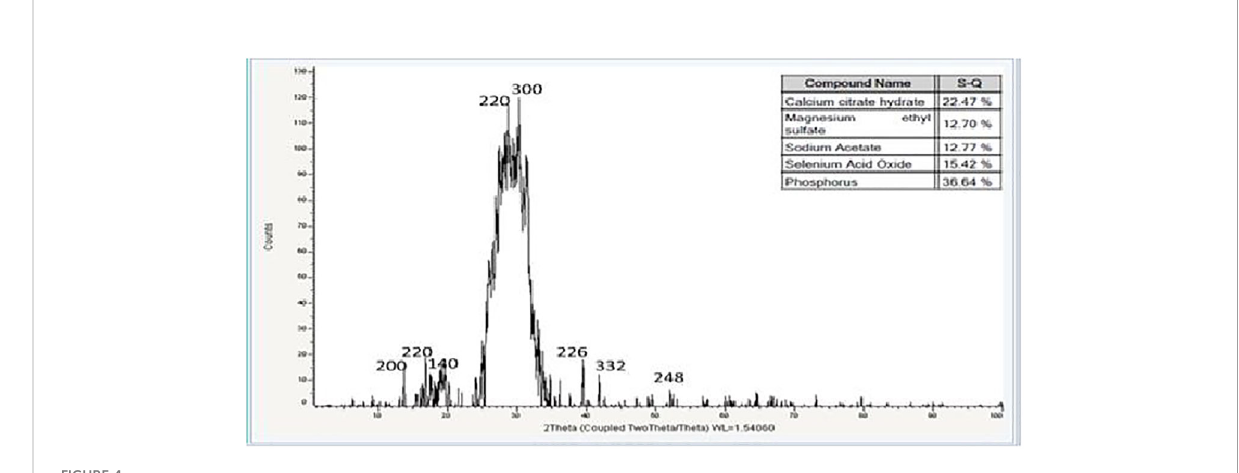
FIGURE 4 XRD spectrum of PoSeNPs.